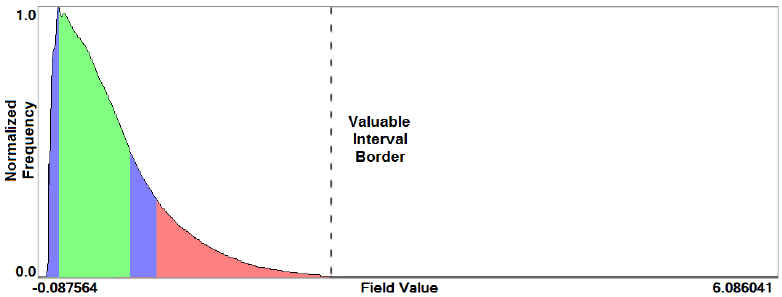
Figure 5. Field distribution histogram (for astrophysical simulation). Field values from the intersection of all time steps’ ranges of all runs are colored in green, from the intersection of all simulations’ ranges (but not for all time steps) in blue, otherwise